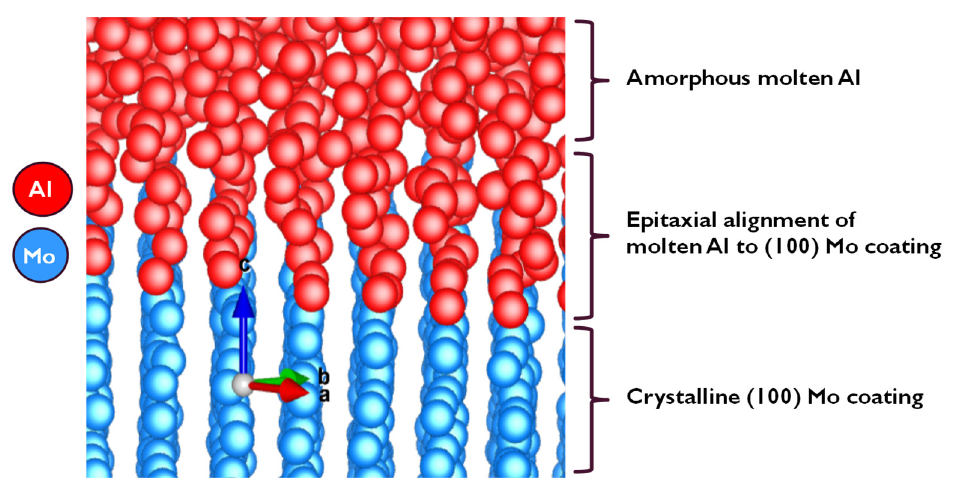
Figure 7. A model depicting the anti ‐ wetting properties of solid metallic Mo in contact with molten Al at 1200 K.